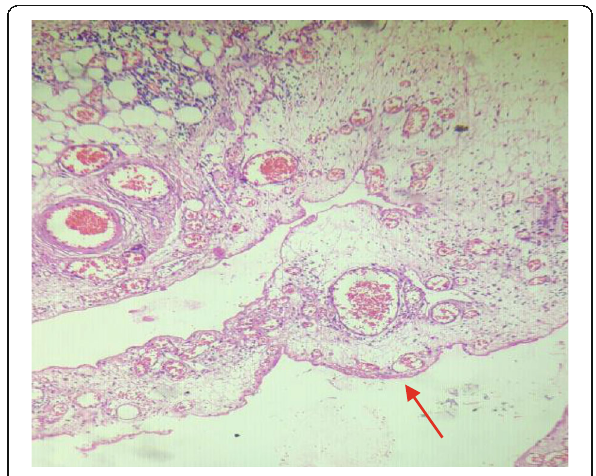
Fig. 6 Showing H and E stained LP (magnification 100x) and HP (magnification 400x) photomicrographs of a cyst wall lined by flattened epithelium (red arrow), congested blood vessels and focal dense infiltration by lymphocytes consistent with a diagnosis of Infected Peritoneal Inclusion Cyst